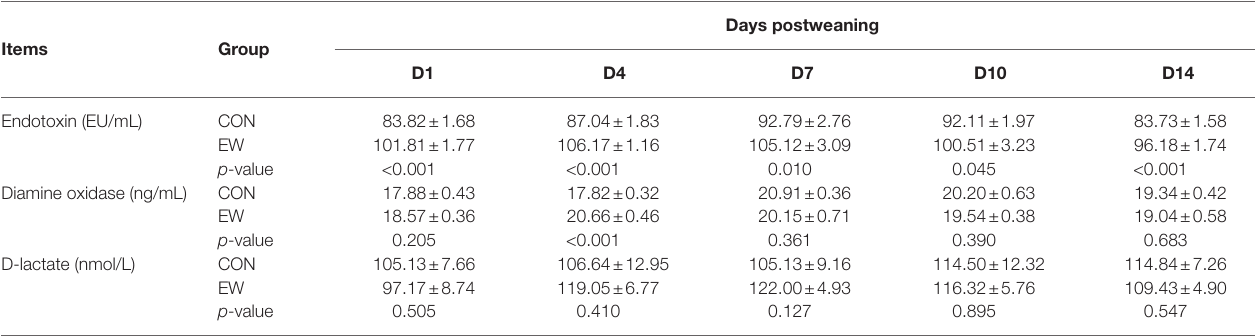
TABLE 2 | Effects of early weaning on intestinal permeability of